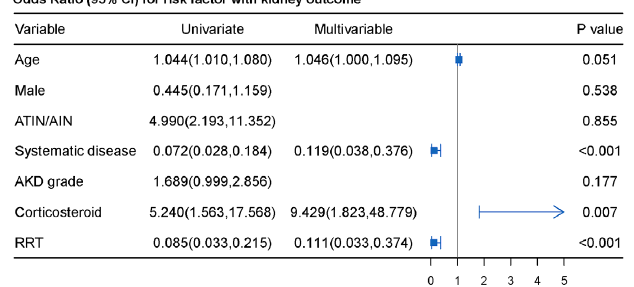
Figure 3. Multiple logistic analysis of factors associated with kidney function recovery in AKD patients. ATIN/AIN: acute tubulointerstitial nephritis/acute interstitial nephritis; AKD: acute kidney disease; CI: confidence interval; RRT: renal replacement treatment.